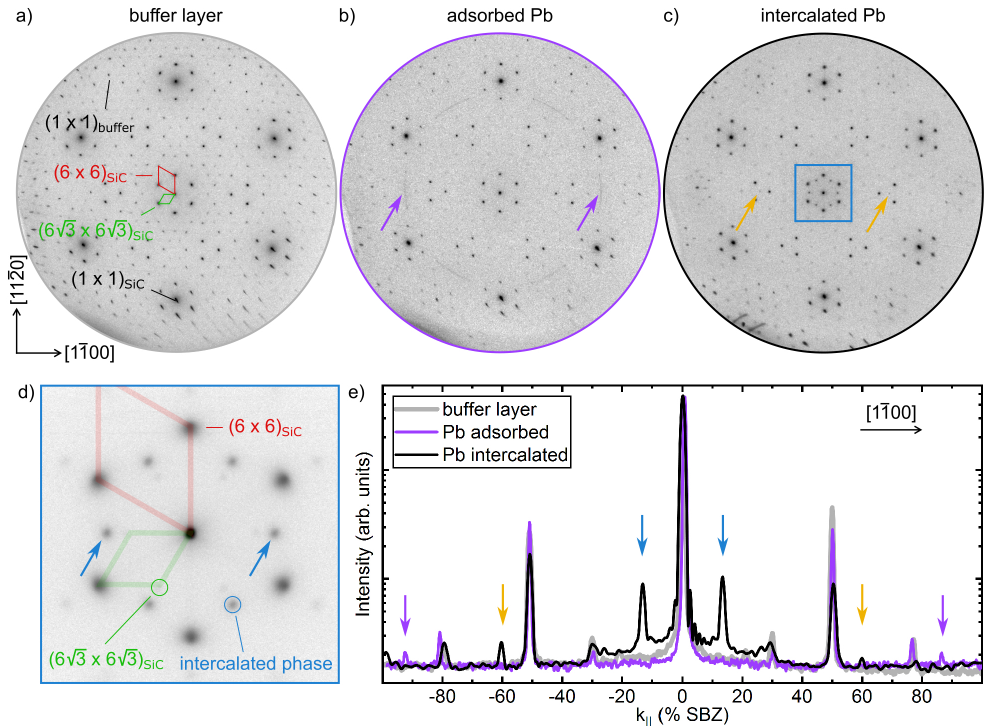
Figure 1. Intercalation process studied by electron diffraction. Sequence of SPALEED images (taken at 100 eV electron energy) of ( a ) pristine BL/SiC(0001), ( b ) after adsorption of 5 MLs of Pb and ( c ) after intercalation of Pb (after adsorption of 5 + 10 ML Pb and annealing cycles). ( d ) Zoom of the (00)-spot after intercalation of Pb (marked in ( c )). ( e ) Line scans taken along the [ 1100 ] -direction for the phases shown in panels ( a – c ). The new reconstruction spots upon Pb intercalation are marked by blue and yellow